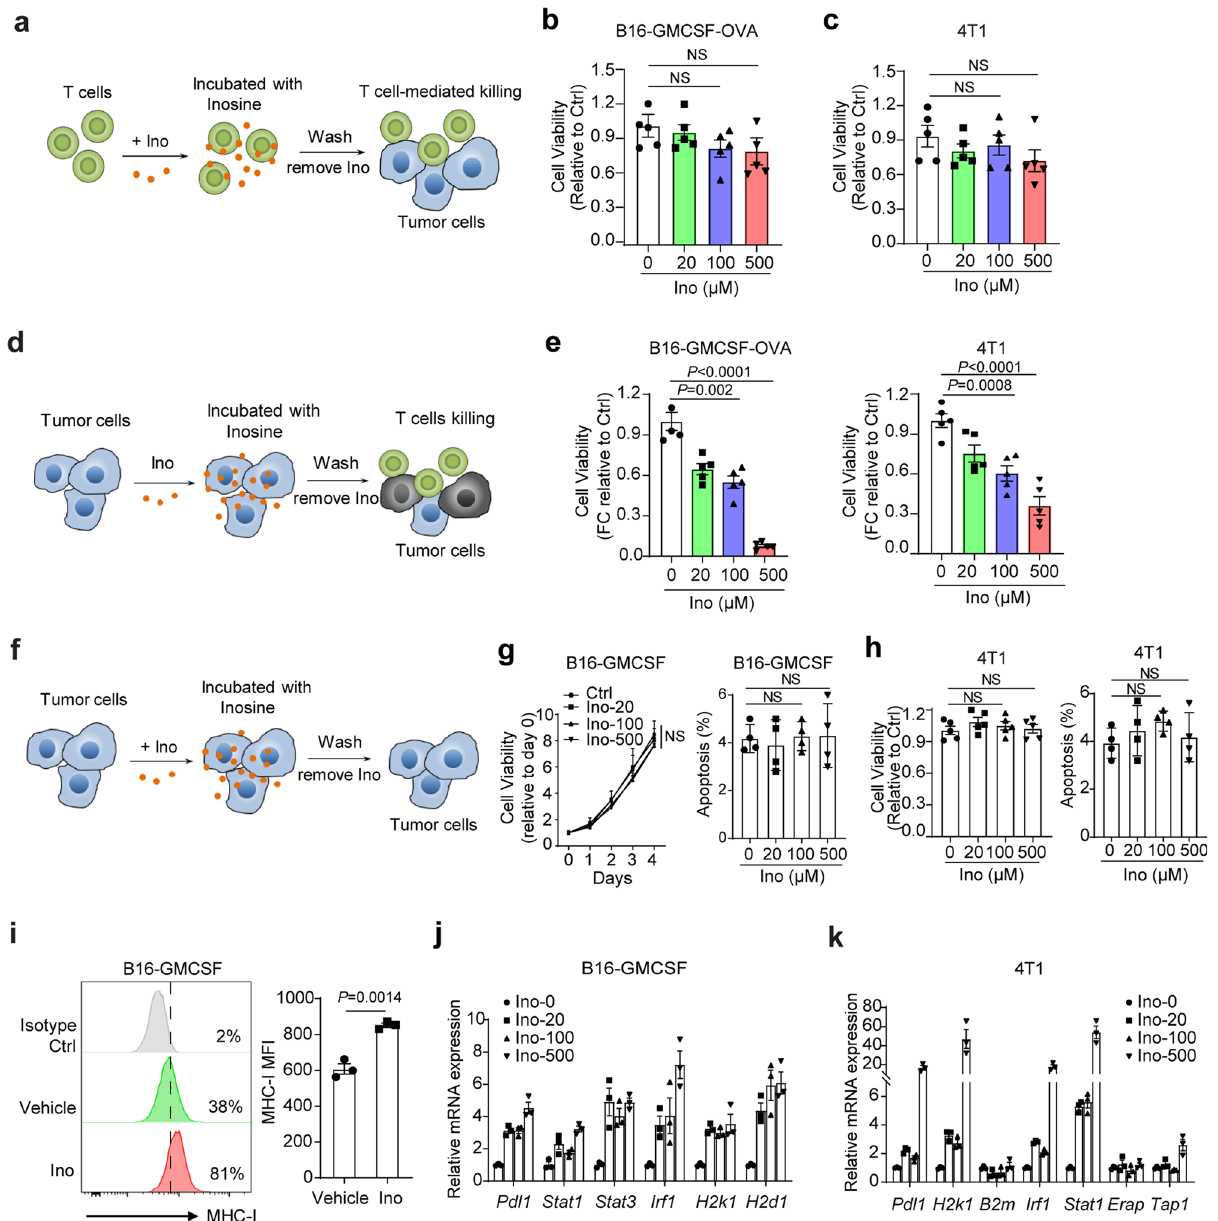
Fig.2|InosinesensitisestumourcellstoT-cell-mediatedkillingbymodulating tumourimmunogenicity.a Experimentalstrategytoevaluatetheabilityofinosine toenhanceT-cell-mediatedtumourkillingbymodulatingTcells. b Therelativecell viability of B16-GMCSF-OVA cells was shown. OT-1 T cells were pretreated with indicated concentrations of inosine or vehicle for 24h, then co-cultured with B16- GMCSF-OVA tumour cells at a 2:1 E: T (Effector: T cells, Target: tumour cells) ratio for 48h ( n =5). c The relative cell viability of 4T1 cells after incubation with acti- vated CD8 + T cells pretreatedwith the indicatedconcentration ofinosine ata5:1 E: T ratio for 48h ( n =5). d Experimental strategy to evaluate the ability of inosine to enhanceT-cell-mediatedtumourkillingbymodulatingTumourcells. e Therelative cellviability ofB16-GMCSF-OVAcells(left) and 4T1 cells (right) withCtrlor inosine treatmentfollowingthemethodin a ( n =5). f Experimentalstrategytoevaluatethe direct effect of inosine on tumour cells. g The relative cell viability (left) and